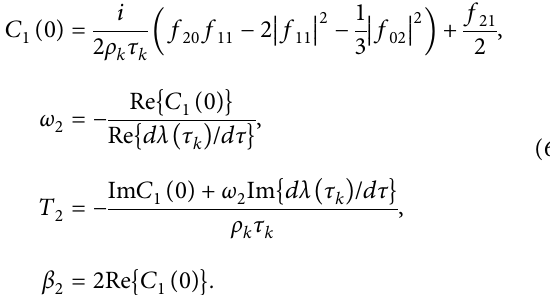
Figure 4: When τ is closer to τ 0 system (1); (b) the time series of z ( t )